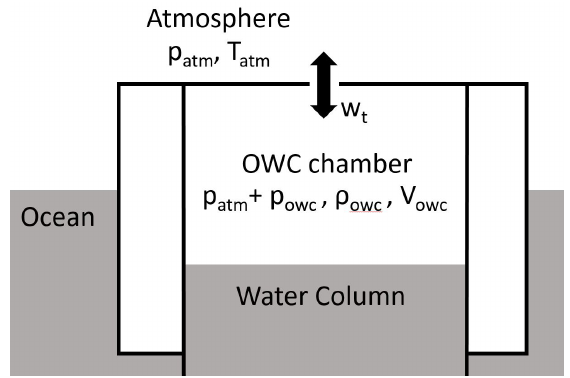
Figure 3. Conventional OWC schematic with thermodynamic